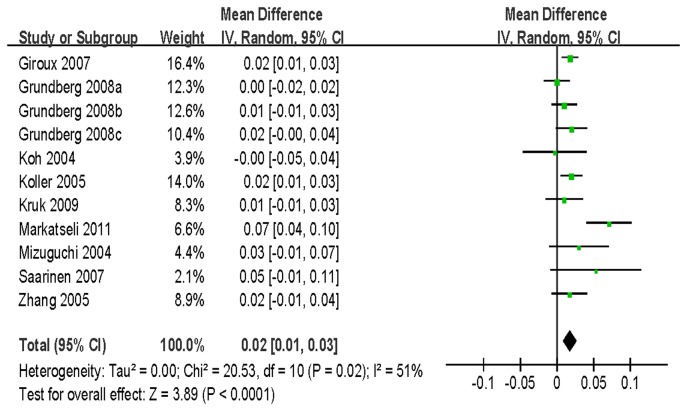
WMD and 95% CI in LS BMD between A1330V AA and AV/VV genotypes.